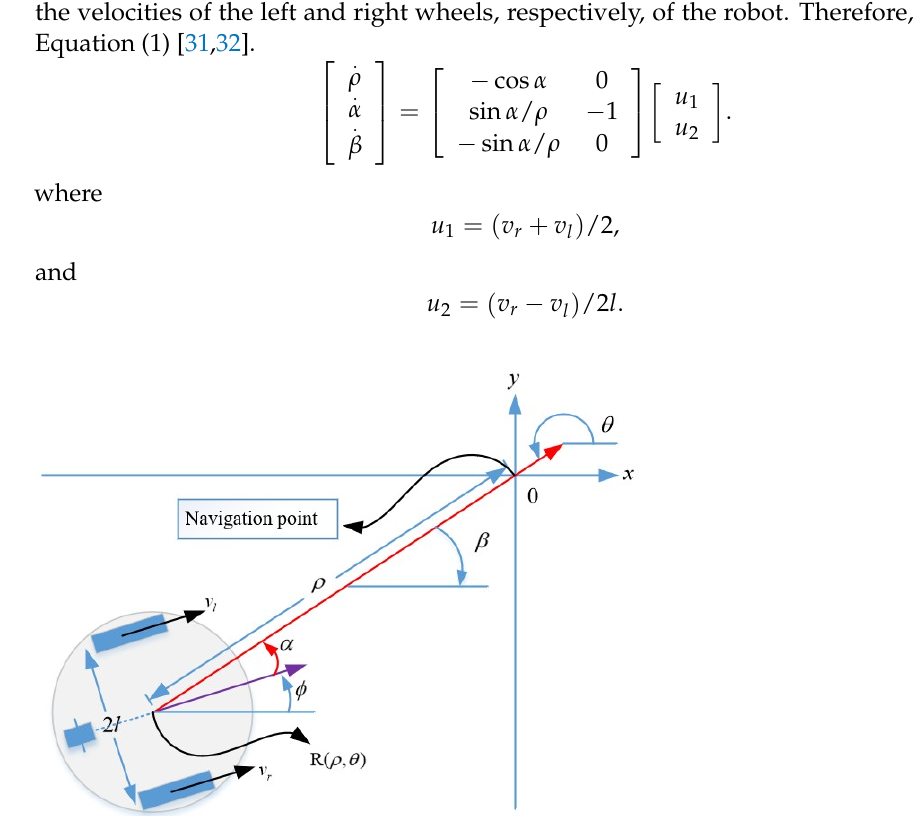
Figure 7. The polar coordinate of the wheeled robot (the purple arrow denotes the moving direction of the robot).